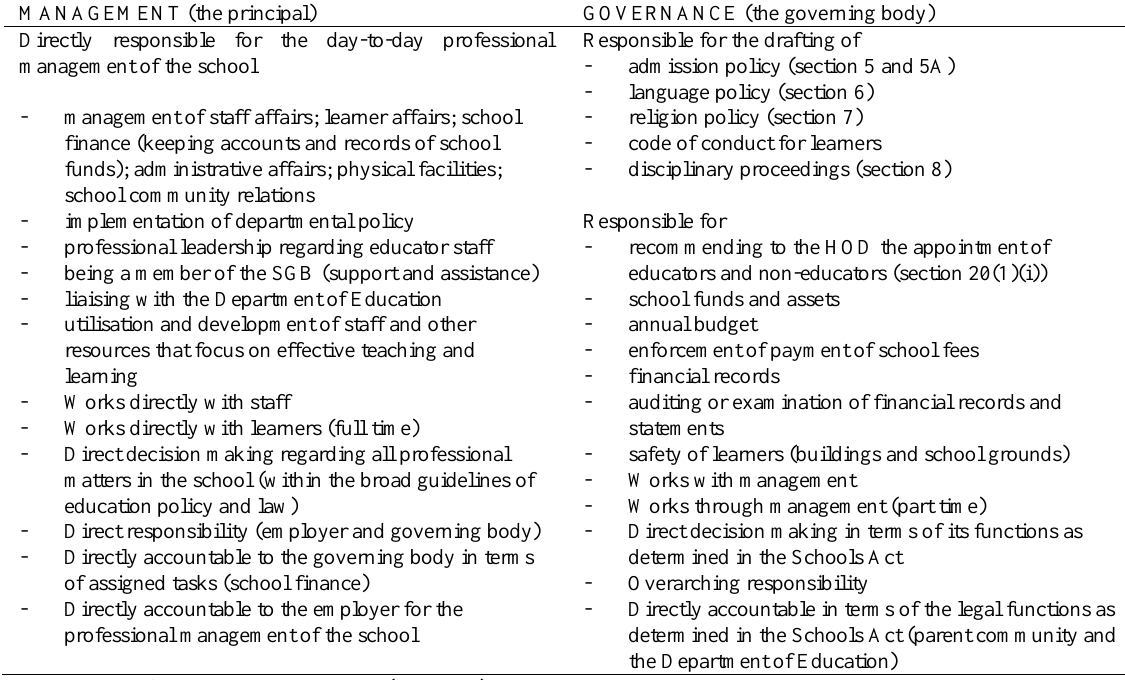
Table 1 Professional management and governance of a public